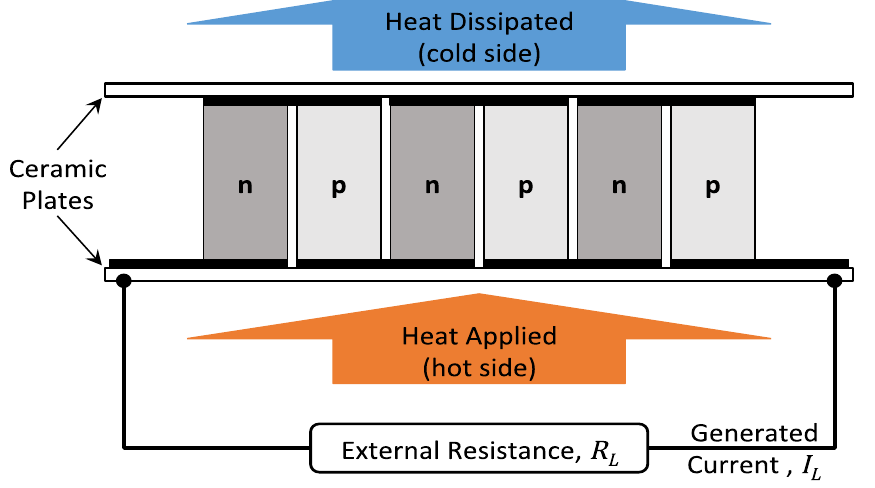
Figure 1. TEG module configuration.